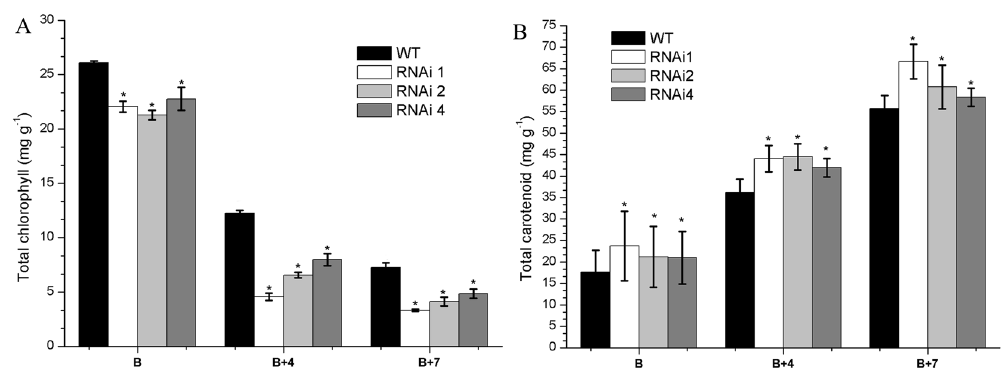
Figure 2. Chl ( A ) and carotenoid ( B ) accumulation profiles between wild type (WT) and SlHDA1 RNAi fruits in pericarp. B, breaker; B + 4, 4 d after breaker stage; B + 7, 7 d after breaker stage. Biological replicates (3–4 fruits per fruit ripening stage) were performed in triplicate, and the data are presented as means ± SD. The asterisks indicate statistically significant differences between the WT and transgenic fruits (P <